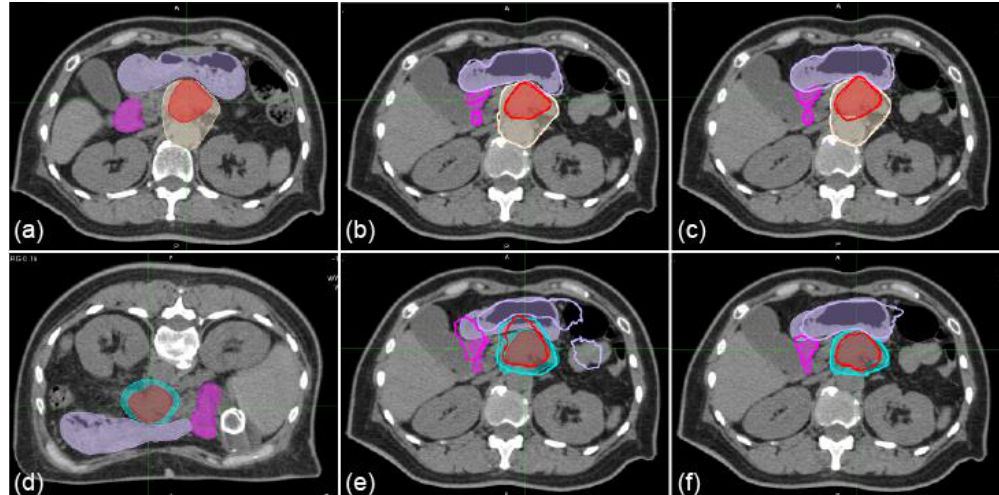
Figure 1. Sample axial images of supine and prone positions with delineated and transferred contours. ( a ) first irradiation day (1st-IRCT). ( b , c ) supine position CT images for treatment planning (SP-PlanCT) images. ( d ) 10th-IRCT images. ( e , f ) prone position (PR)-PlanCT images. Filled red, beige, cyan, mauve, and magenta regions show delineations of the gross tumor volume (GTV), clinical target volume 1 (CTV1), CTV2, stomach, and duodenum, respectively. Bold red, beige, mauve, and magenta regions show the GTV, CTV1, stomach, and duodenum transferred from the 1st-IRCT to SP-PlanCT images with intensity-based deformable image registration (iDIR) ( b ) and contour-based DIR (cDIR) ( c ). Bold red, cyan, mauve, and magenta regions show GTV, CTV2, stomach, and duodenum transferred from PR-PlanCT images to SP-PlanCT images with iDIR ( e ) and cDIR ( f ).